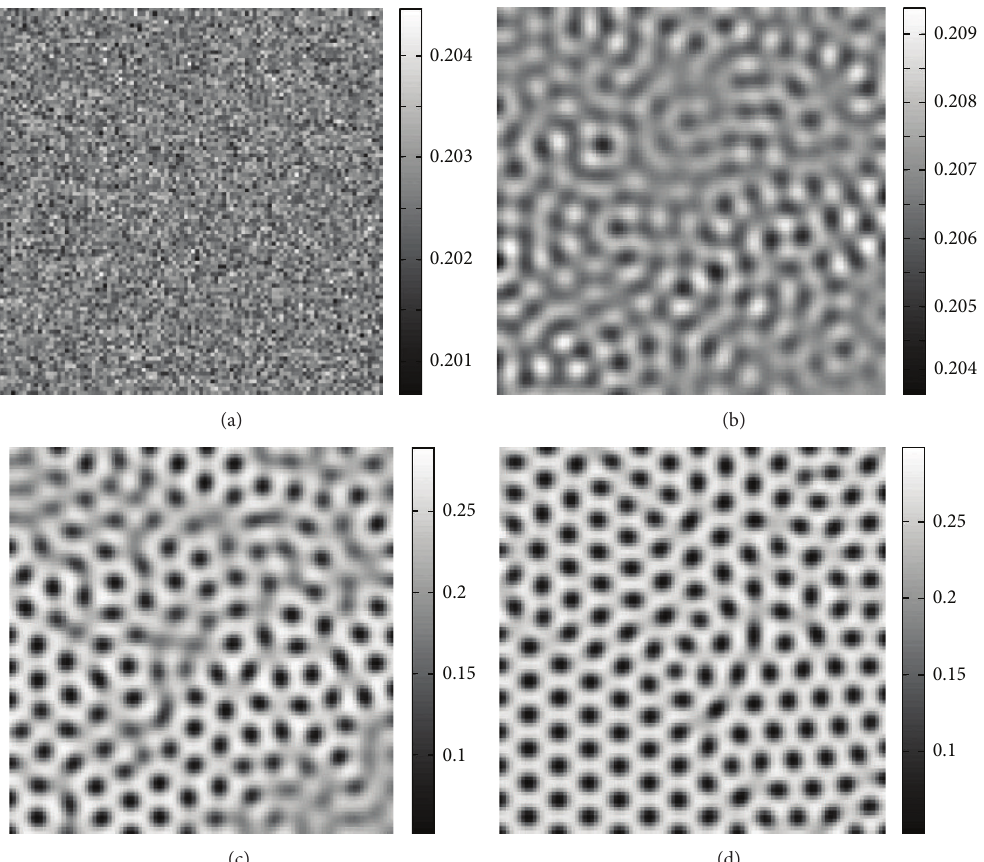
Figure 2: Holes pattern of the prey 𝑢 obtained with model (3) with 𝑐 1 = 1.84 and 𝑞 1 = 0.6 . Iterations: (a) 0 , (b) 20000 , (c) 60000 , and (d) 200000 .